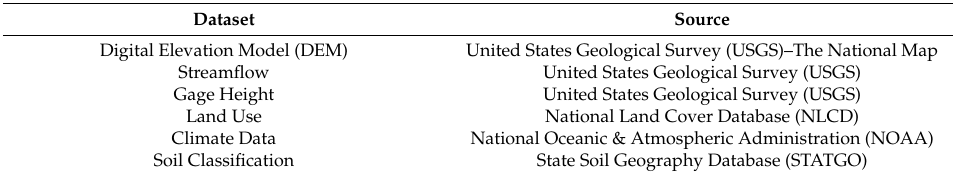
Table 1. Datasets and their sources used for creating the combined modeling system.